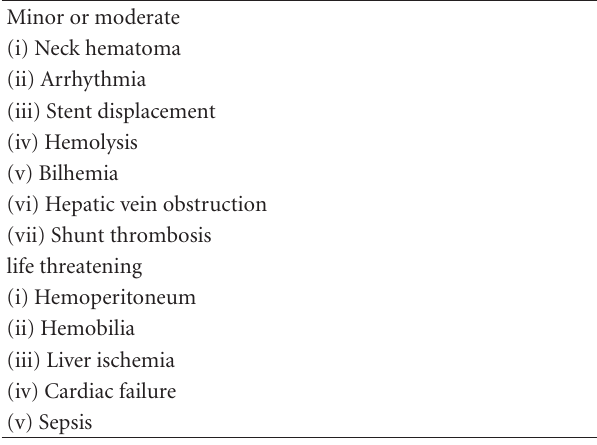
Table 1: Contraindications for the TIPS procedure. Absolute